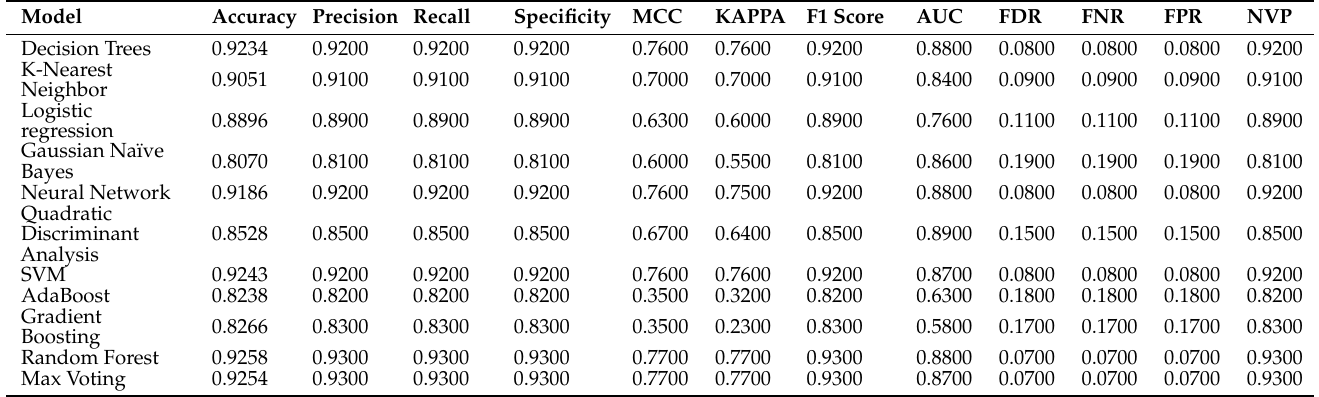
Table 6. Result of Dataset 3 using the Machine Learning Algorithms and Ensemble learning